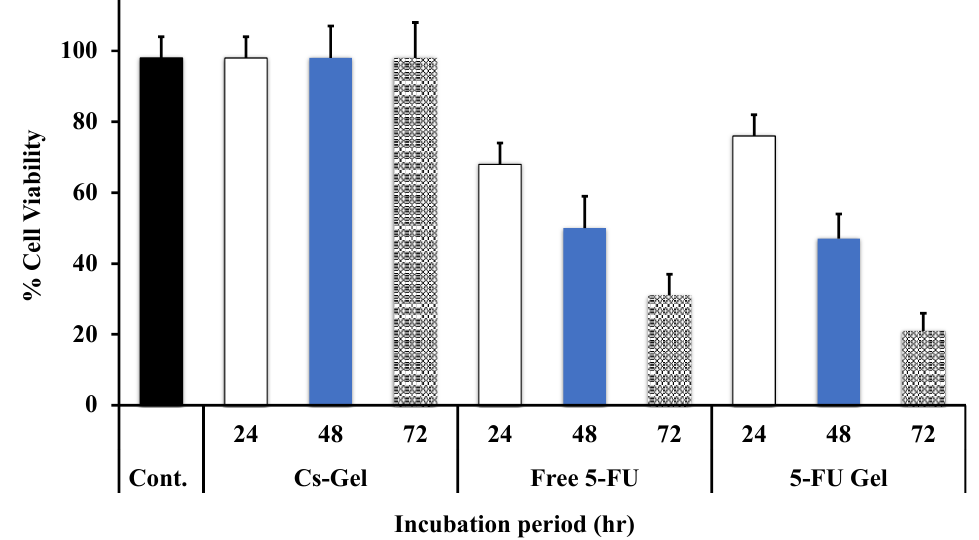
Figure 3. Cytotoxicity studies of 5-FU-loaded Cs/ β -GP + PL hydrogel on MCF-7 cells in comparison with either blank chitosan hydrogel or free drug solution, as a function of the incubation period (concentration was fixed at 200 µ g/mL). The obtained results are shown as the mean of three experiments ± SD.